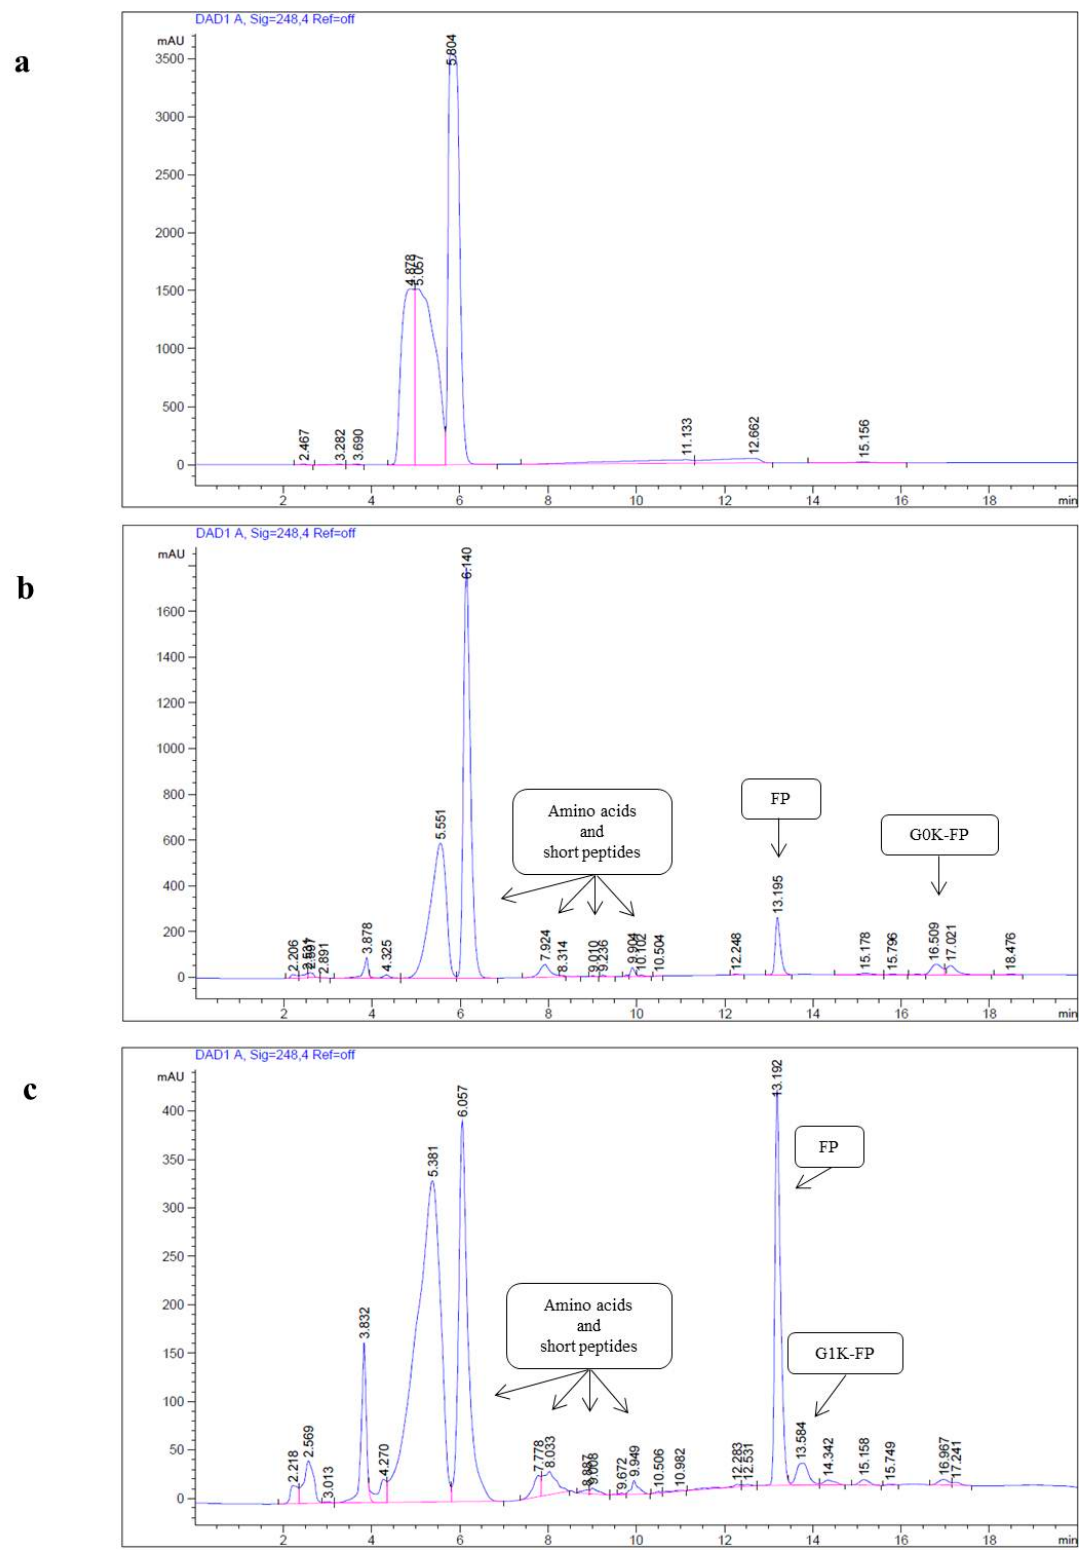
Figure 7. HPLC analysis of: ( a ) Acidic buffer only (background); ( b ) G0K-FP and ( c ) G1K-FP in an acidic buffer (phthalate) solution of pH 4.5. The peaks at the beginning of the HPLC run, before 6 min, are related to the buffer (background), whereas at 13.1 min elution represents free drug. The remaining detected peaks are likely representing the amino acid residues used during synthesis of the dendrons or the shorter peptides that formed due to the breakdown.